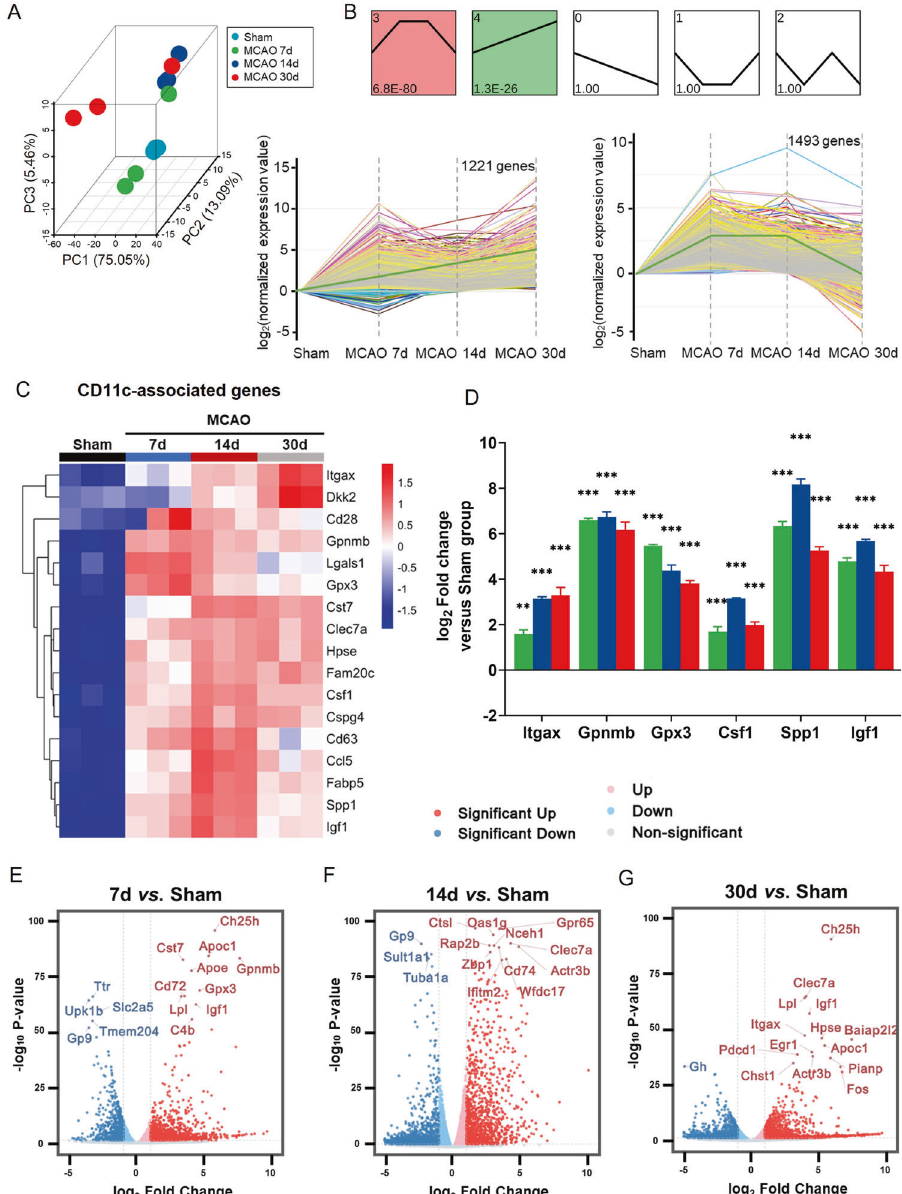
Fig. 3 Microglia in the repairing phase of stroke exhibited molecular signatures associated with CD11c population. A 3D Principal Component Analysis (PCA) of the 12 samples in Sham, tMCAO 7 Day, tMCAO 14 Day, and tMCAO 30 Day groups. B The expression patterns of the genes were analyzed, and 5 model pro fi les were used to summarize the data. Each box represented an expression model pro fi le. The upper number in the pro fi le box represents the model pro fi le number and the lower number indicates the p value. Two gene expression patterns showed signi fi cant p values ( p < 0.05) (coloured boxes). Pro fi le NO. 4 and 3 were the signi fi cant pro fi les including 1221 and 1493 genes, respectively. The general trend lines were green. Cluster heatmaps showing upregulation of CD11c-associated genes ( C ) on the 7 – 30 Day post-tMCAO. D qPCR for Itgax, Gpnmb, Gpx3, Csf1, Spp1, Igf1 . n = 3 per group. ** p < 0.01, *** p < 0.001 compared to sham group, values were mean ± SEM. Volcano plots displaying the top 15 genes according to − log 10 p value on the 7 ( E ), 14 ( F ), and 30 Day ( G ) versus